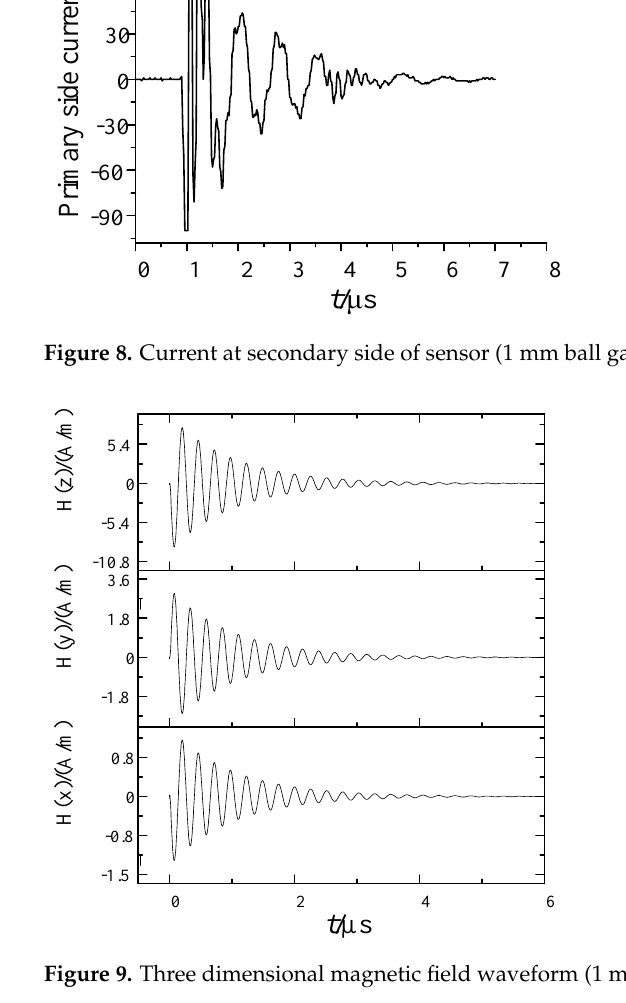
Figure 9. Three dimensional magnetic field waveform (1 mm ball gap).